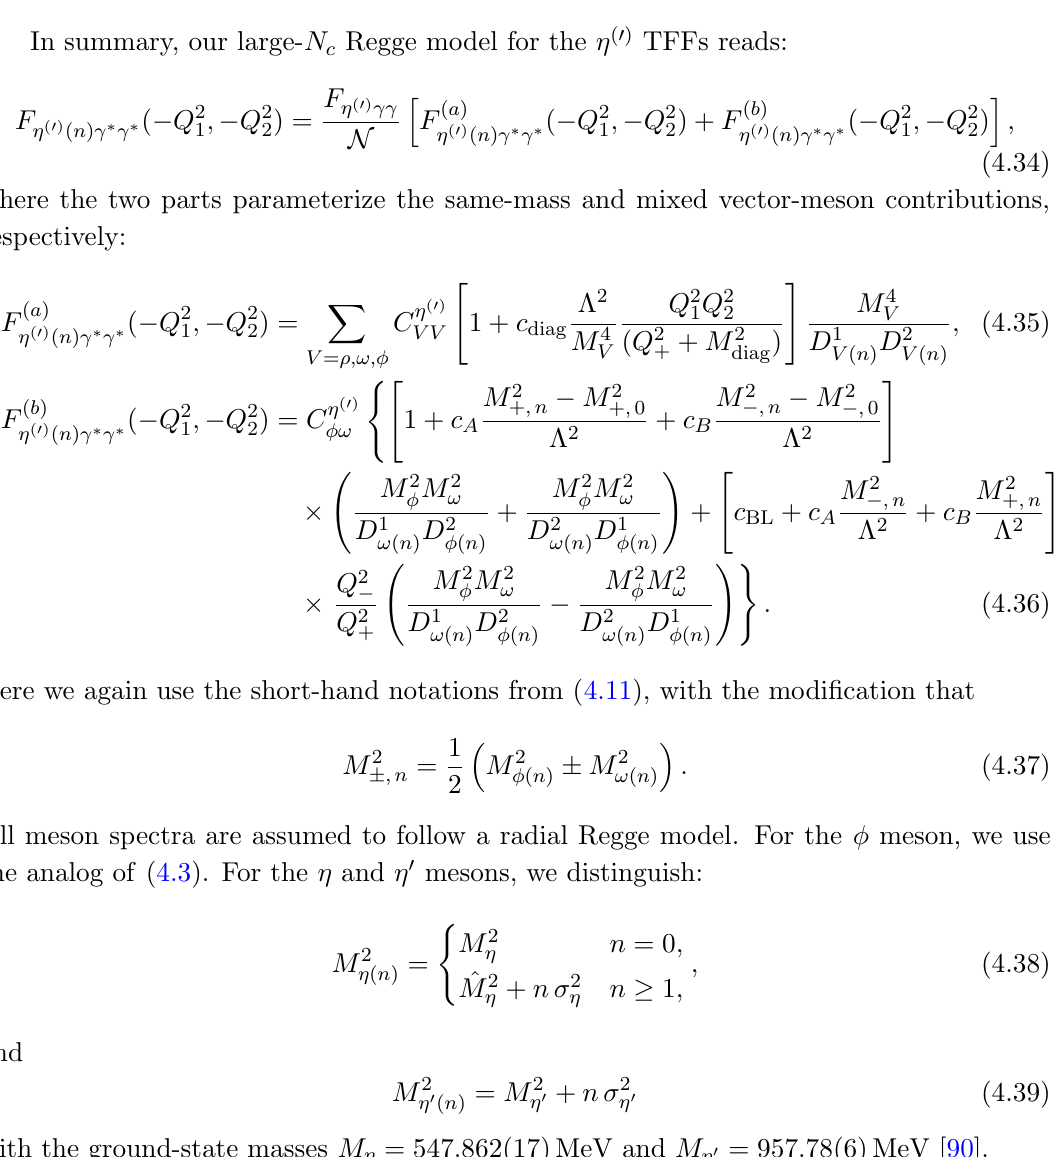
Table 2. Pseudoscalar-vector-vector couplings derived in appendix A: C P V i = (cid:26); !; (cid:30) as de(cid:12)ned in (A.9) and